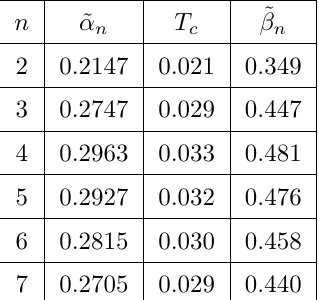
= (cid:0) 8 and (cid:22) 2 1